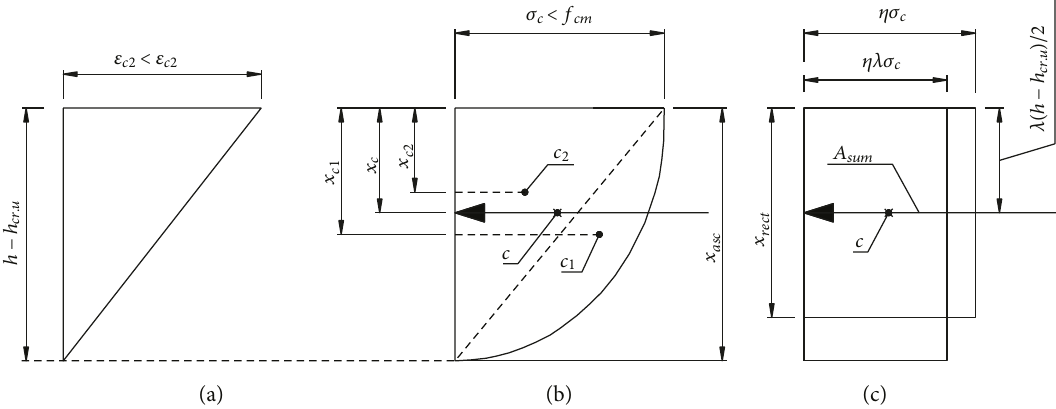
Figure 7: Stress distribution diagrams for concrete in compression, when mean value of concrete compressive strength is not reached: (a) strains in cross-section; (b) curvilinear concrete compressive zone stress diagram; (c) rectangular stress